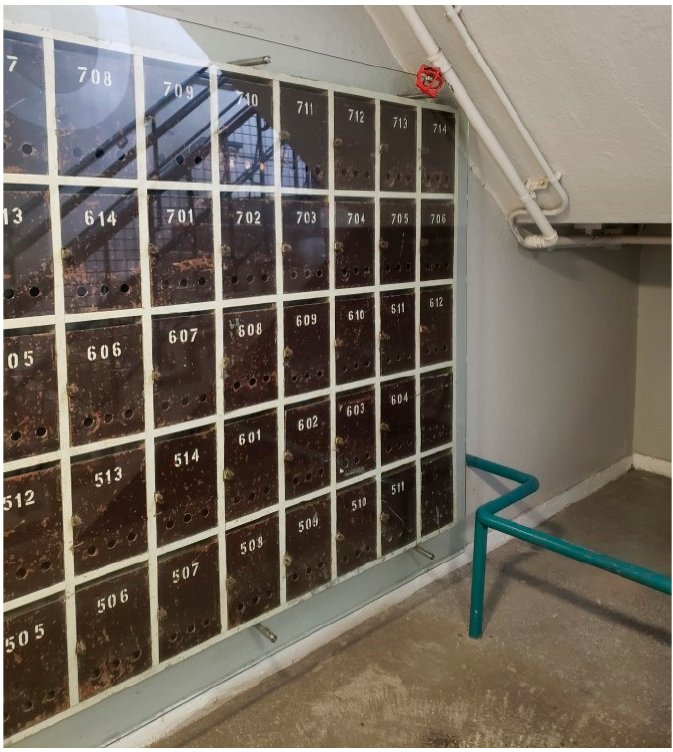
Figure 3. Old mailboxes kept in PMQ.